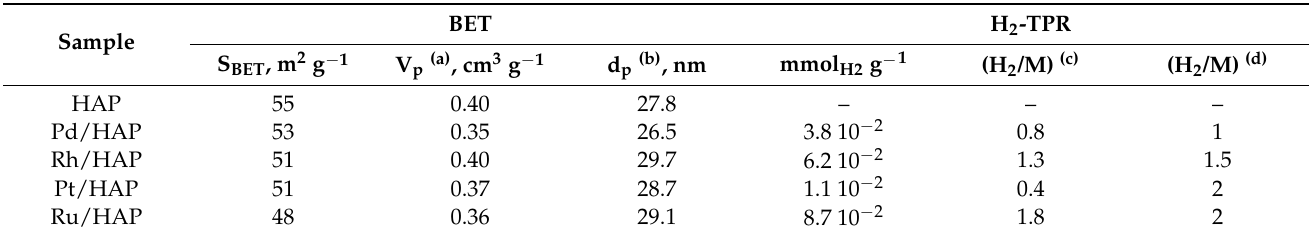
Table 1. Characterization data of the noble metal